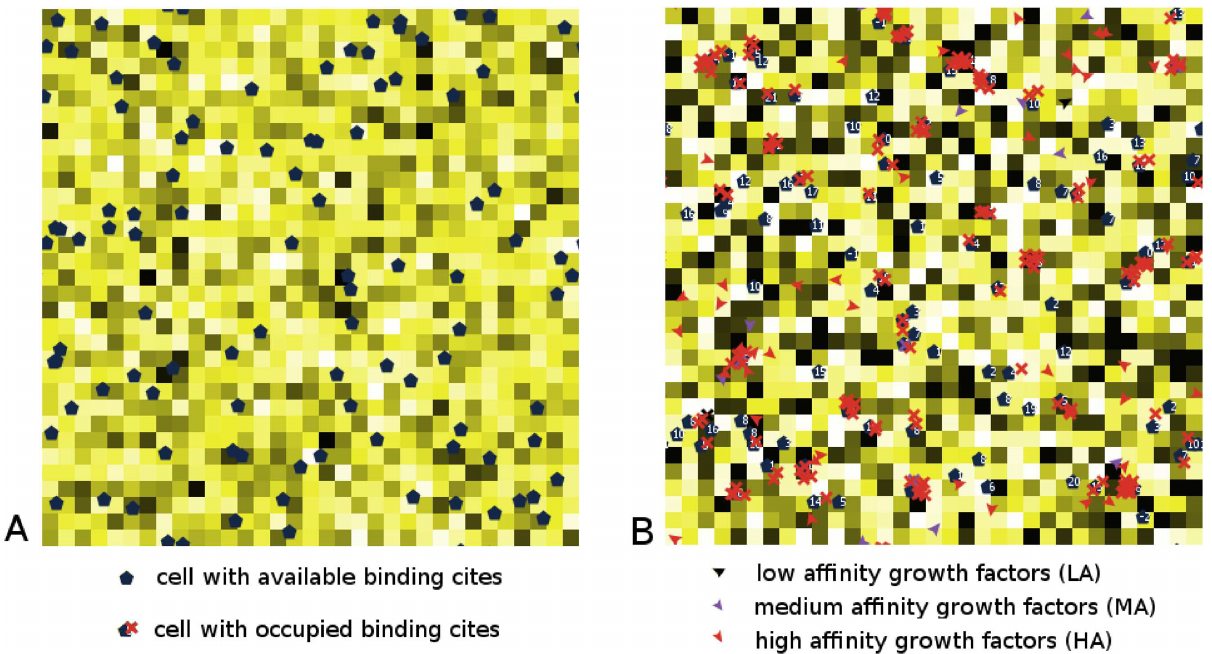
Fig 2. A snapshot of the proposed agent-based model. (A) Model initialization.The grid is populatedby cells, which are characterized by pre-determined number of bindingsites. The color changesin the microenvironments representheparinaseconcentration. Darker patches correspondto higherconcentrations of heparinase;lighter patches correspond to lower levels of heparinase. (B) After the simulationhas begun, the growth factors LA, MA and HA mode randomly throughoutthe grid. Once they encounter a cell with free bindingsites (red crosses), they occupy them, and thereby decreasing the numberof availablesites (numbersby the cell agents decreases, reflecting the number of available sites). Growth factors become cleaveddependingon the current concentration of heparinasein the corresponding microenvironment. The NetLogocode for this model is attached in